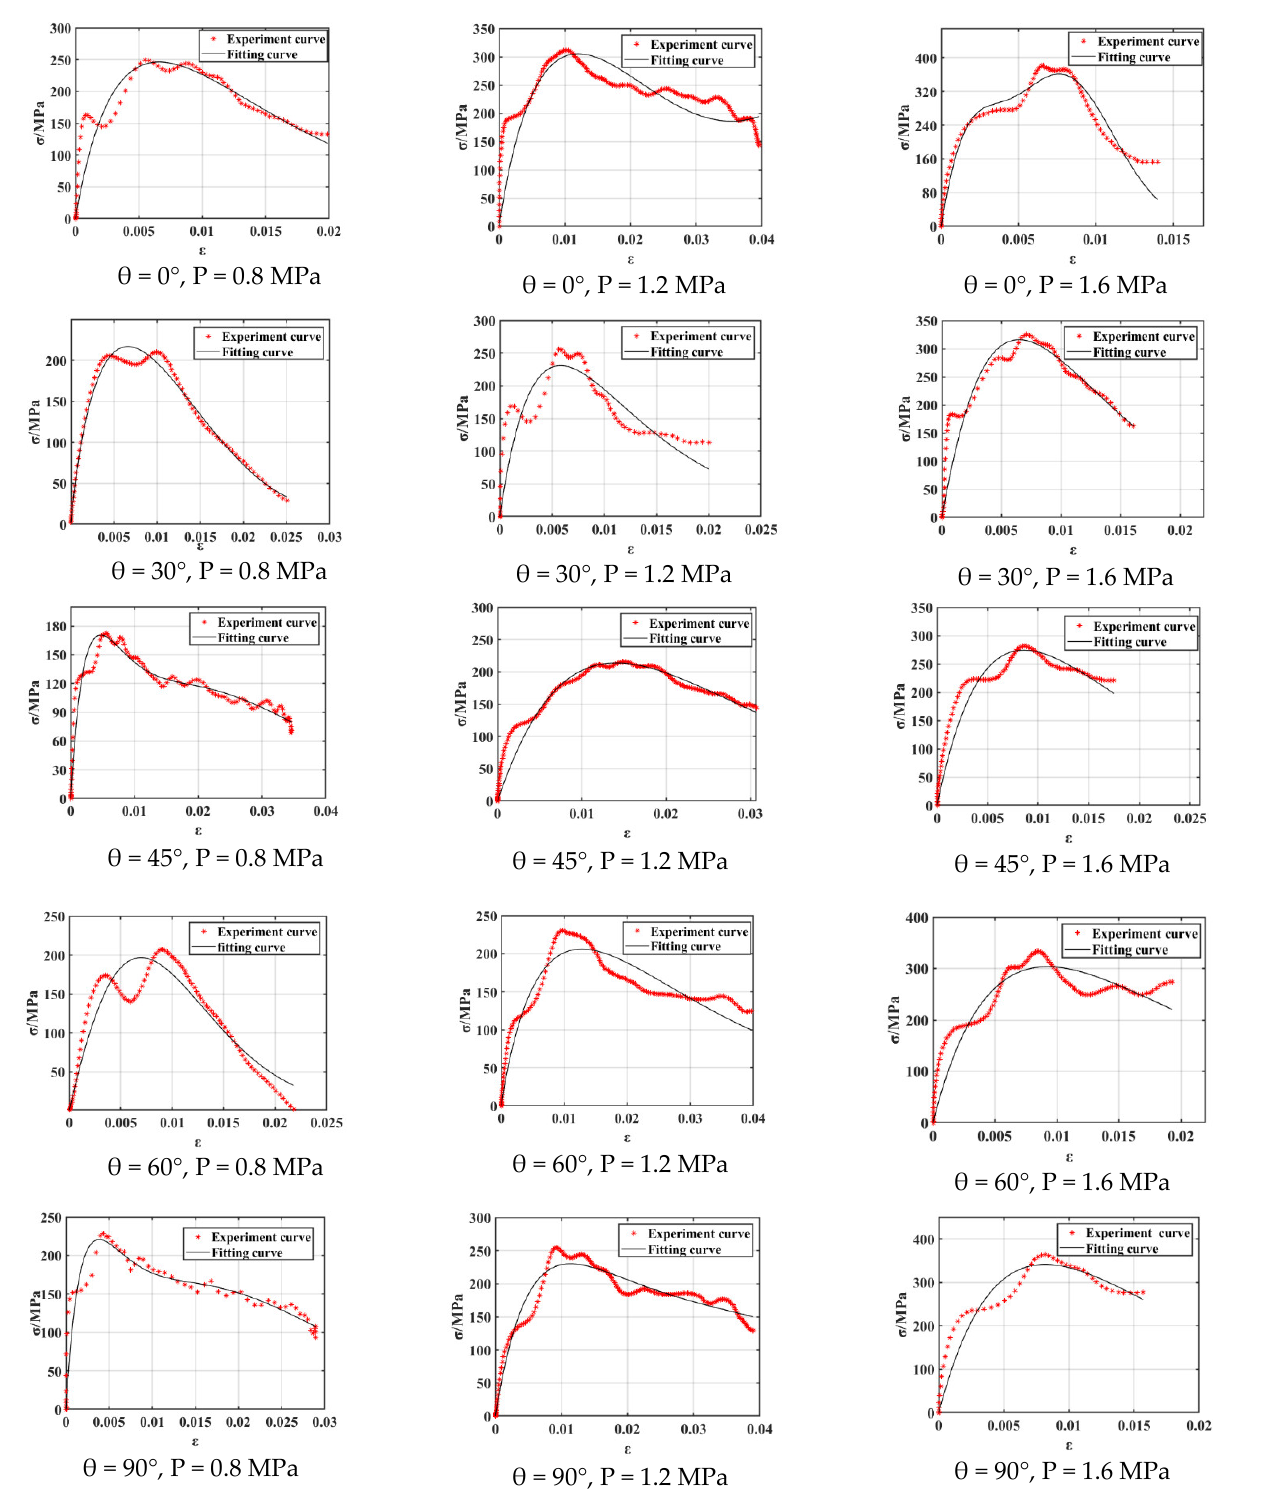
Figure 16. Modified constitutive model and its verification. Table 4. Parameters of the rock constitutive model.